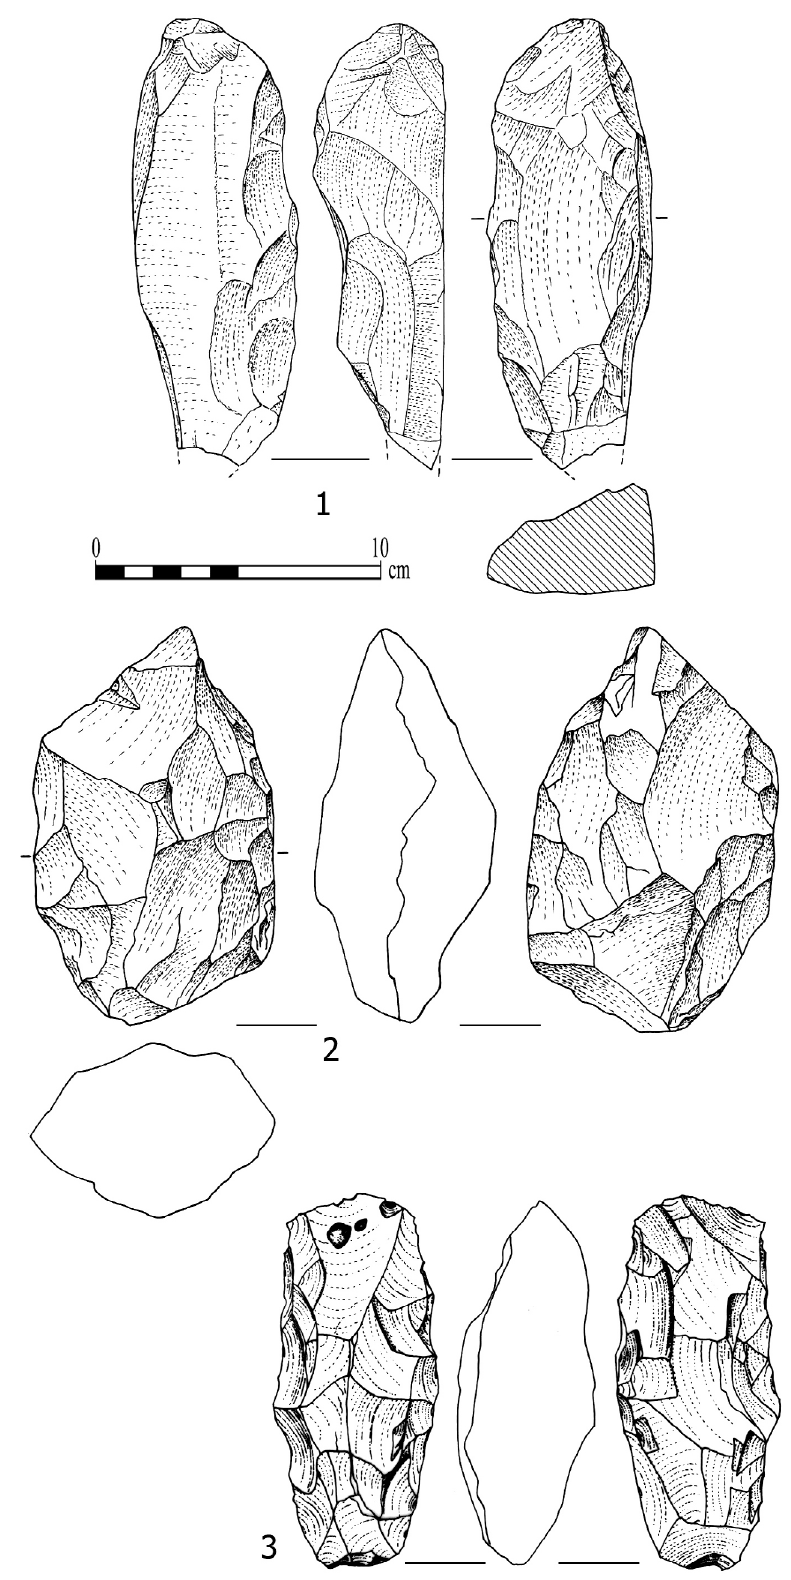
Figure 9. Basanite rough-outs from Locus